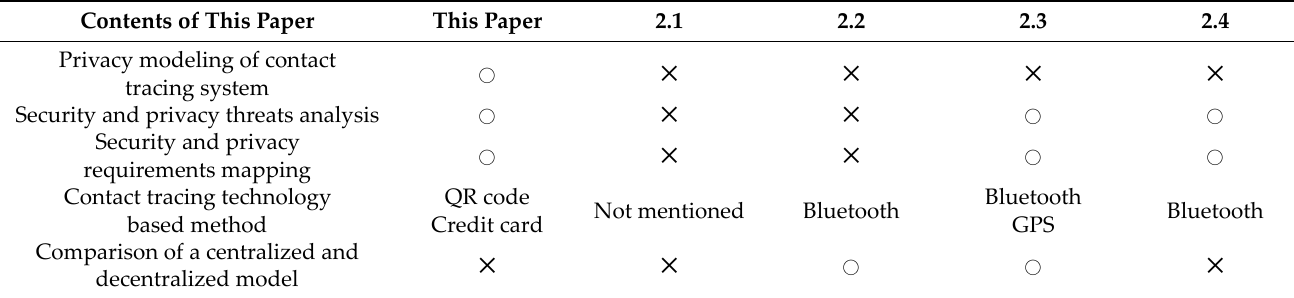
Table 1. A comparison of this paper and the related